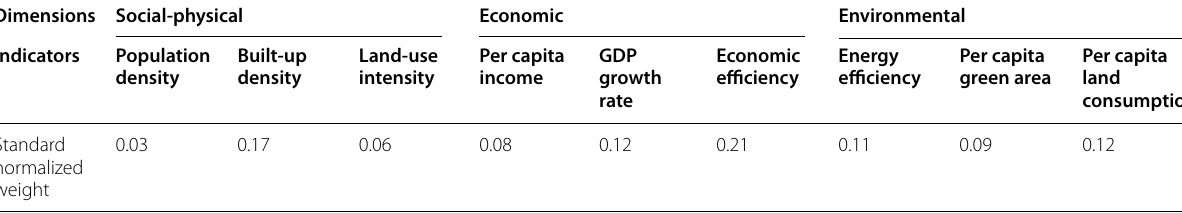
Table 8 Score of sustainability